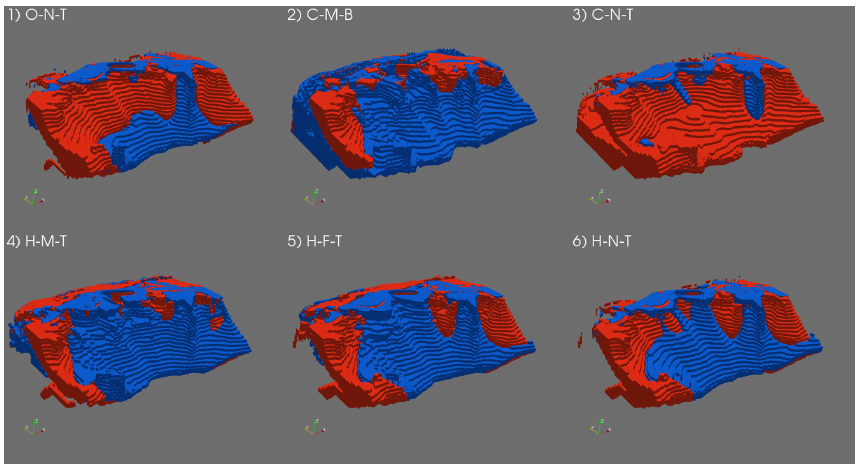
Figure 8. Comparison between the palaeohydrogeological reconstructions and the steady-state model scenarios. Red colours indicate that (cid:49) C > 1, meaning that the palaeohydrogeological reconstruction is saltier than its steady-state equivalent. Vice versa for blue, where (cid:49) C < − 1. All values in between − 1 and 1 are made transparent to focus purely on major differences. Groundwater below 450m depth is not plotted, as the present-day fresh–salt interface was not located below these depths. The camera angle is the same as in the six bottom plots of Fig. 4.